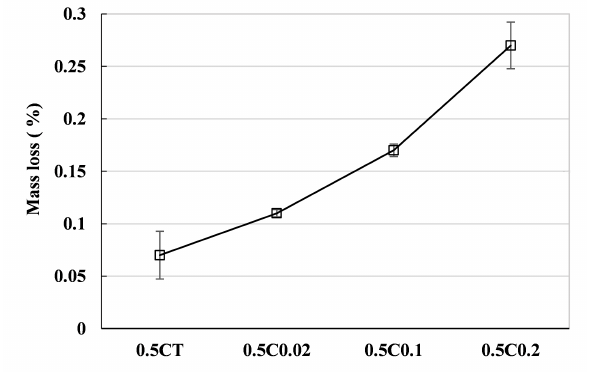
Figure 11: Mass loss of steel